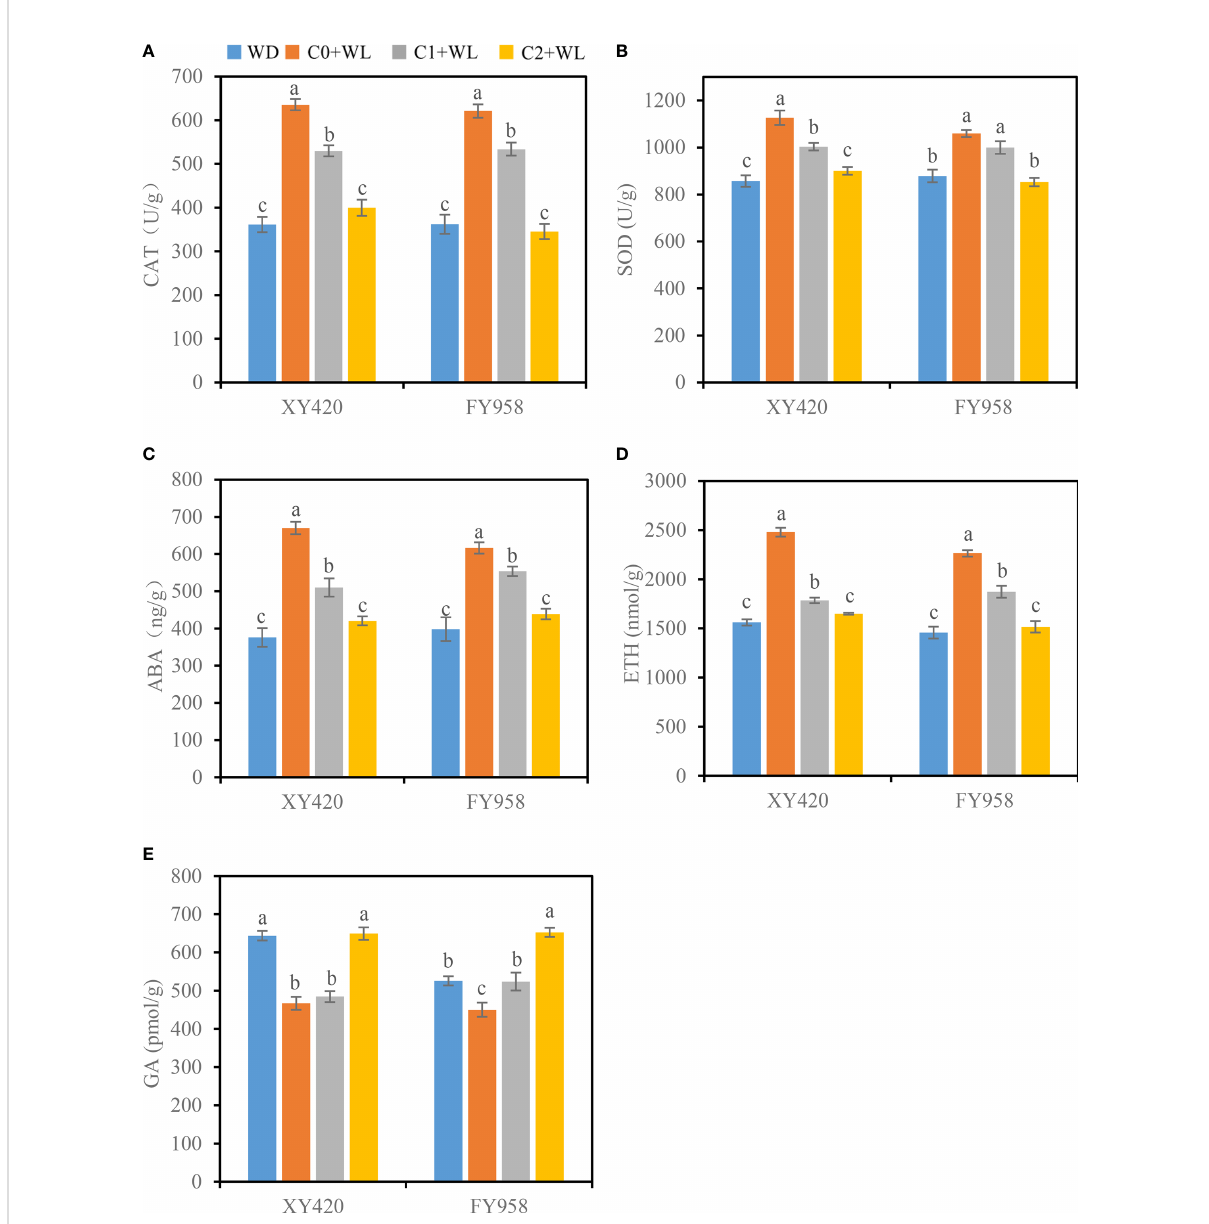
FIGURE 3 Effect of CaO 2 on the activities of antioxidant enzymes and hormone contents in the leaves under waterlogging conditions. (A) , CAT, catalase; (B) , SOD, superoxide dismutase; (C) , ABA, abscisic acid; (D) , ETH, ethylene; (E) , GA, gibberellin. Error bars represent standard errors. Different letters above bars indicate signi fi cant differences between planting patterns at P < 0.05. WD, well-draining, C0+WL, no CaO 2 and waterlogging, C1+WL, 594 kg hm -2 of CaO 2 in the form of base fertilizer and waterlogging, and C2+WL as in treatment C1+WL but a supply of 864 kg hm -2